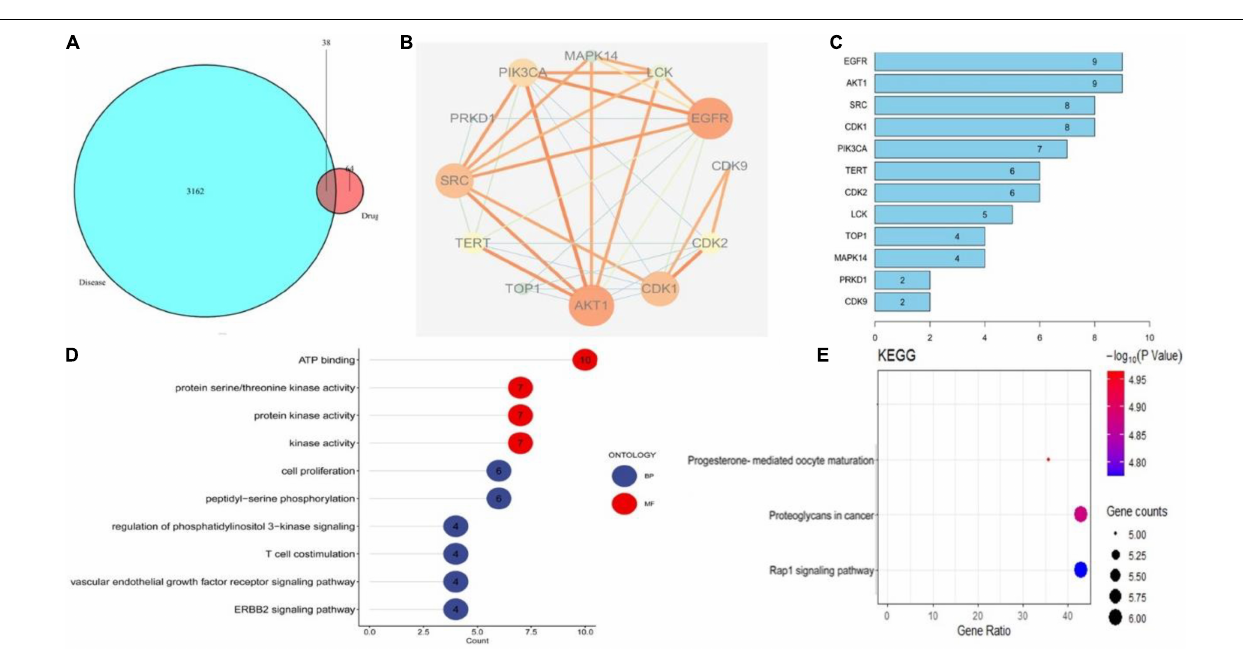
FIGURE 3 | The drug-target interactions predicted by network pharmacology. (A) The intersection of drug and disease targets. (B) Compound-target-pathway network. (C) Protein target interaction (PP1) network of intersecting targets. (D) GO terms enrichment analysis (Molecular Function, Biological Process). (E) KEGG pathway enrichment